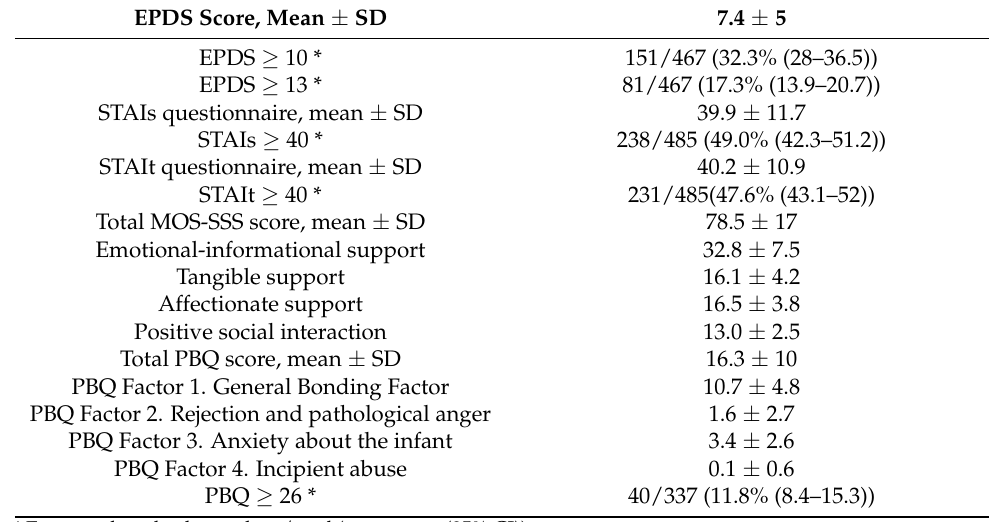
Table 2. Descriptors of depression (EPDS) and anxiety (STAI) symptoms, social support (MOS-SSS), and infant-to-mother bonding